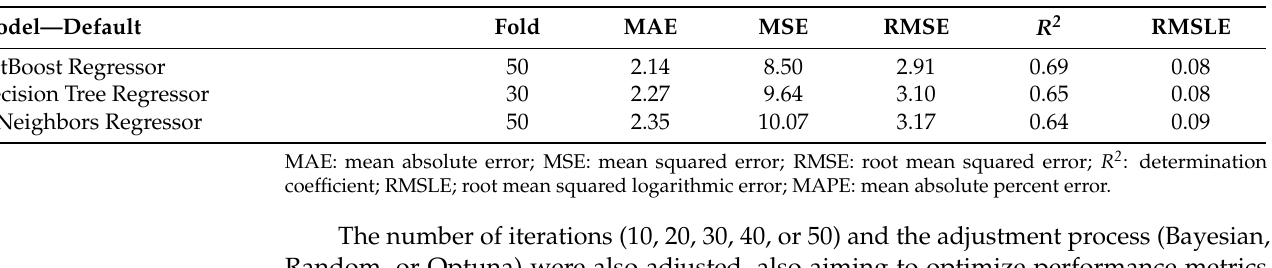
Table 4. Selection of the “Fold” value, analyzing the determination coefficient and mean squared error metrics.